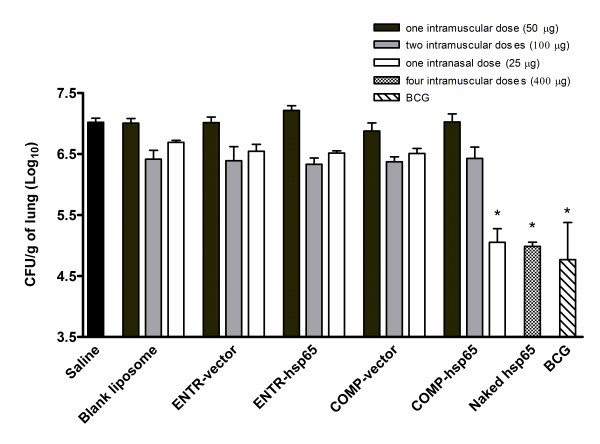
Determination of M. tuberculosis growth in lungs from mice immunized with liposomes by different routes. BALB/c mice were immunized by: a) a single dose or two doses of liposomes (50 μg of DNA each) by intramuscular injection at a 15-day interval, b) a single dose of liposomes (25 μg) by intranasal instillation, c) four doses of naked DNA (100 μg each) by intramuscular route at a 15-day interval or d) one dose of BCG (Moreau strain) given by subcutaneous injection of about 105 live bacteria in 100 μl saline. Thirty days after the last dose, mice were challenged intra-tracheally with M. tuberculosis H37RV and 30 days post infection we performed CFU analysis. Data represent the mean log10 CFU counts ± SD of six mice per group of one of three independent experiments. *p < 0.01 were considered significant when compared to the saline group.